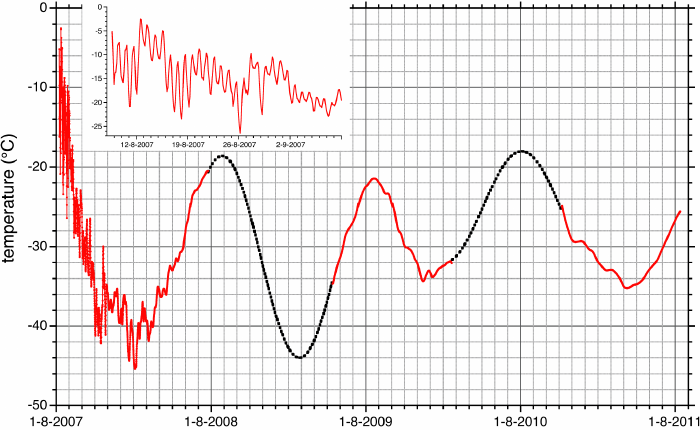
Figure 4. The temperature registration of the thermocouple, at the same depth as the layer. The dashed lines are interpolations for the times we did not have temperature measurements available. The insert shows the first month of data in detail.